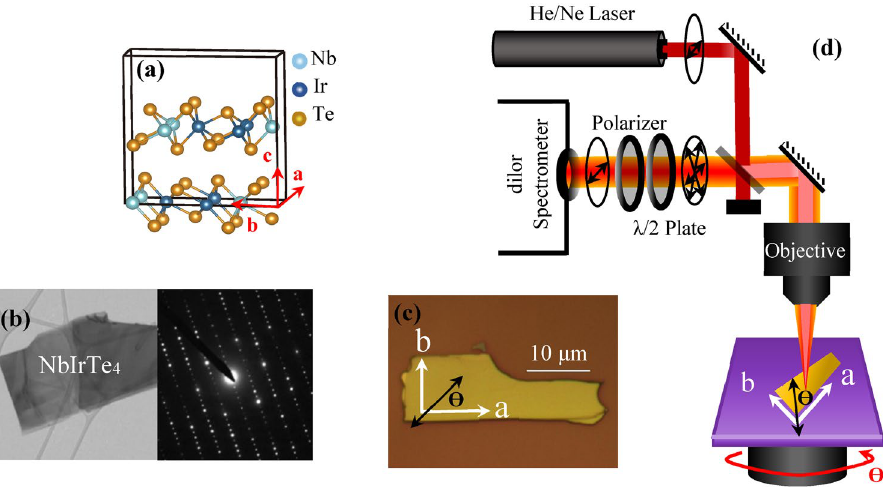
Figure 1. ( a ) Schematic side perspective of crystal structure of NbIrTe 4 . ( b ) TEM image and TEM diffraction pattern of NbIrTe 4 along c-axis. ( c ) The optical image of the NbIrTe 4 sample including ‘a’ and ‘b’ crystal line axes and the polarization direction of the incident light. ( d ) The schematic diagram of polarized Raman measurement with rotational